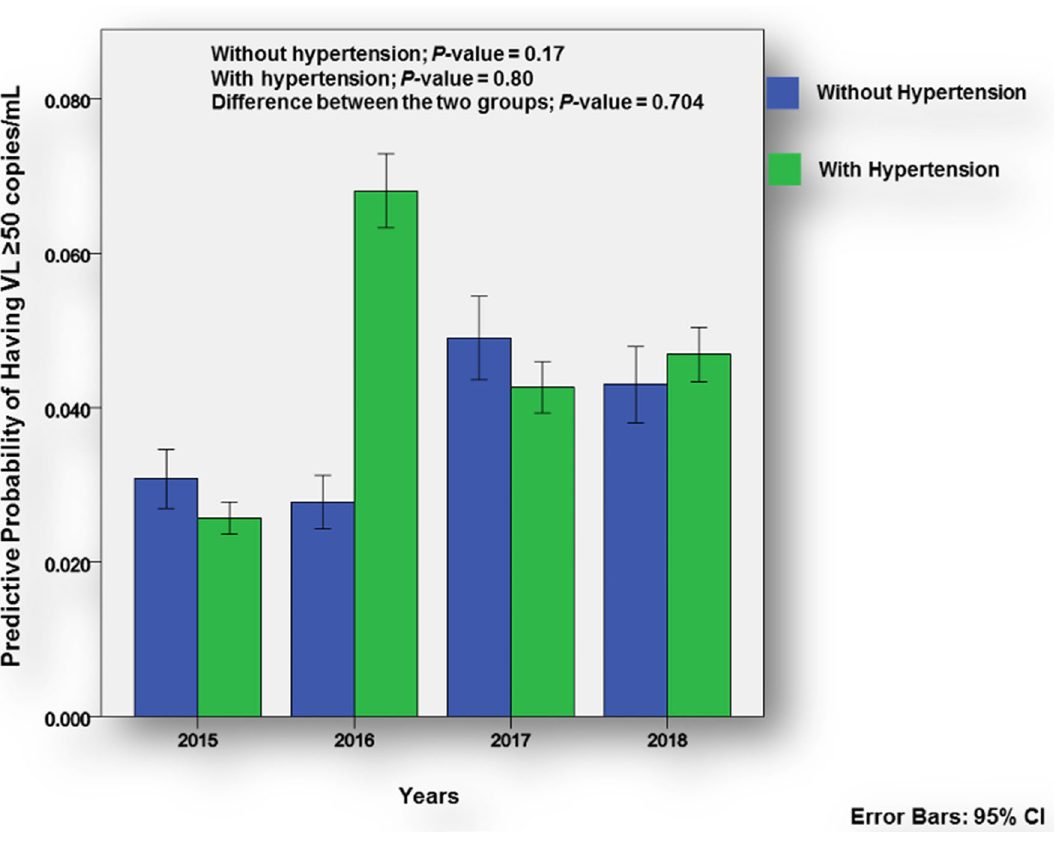
Figure 2. Predictive probability in relation to viral